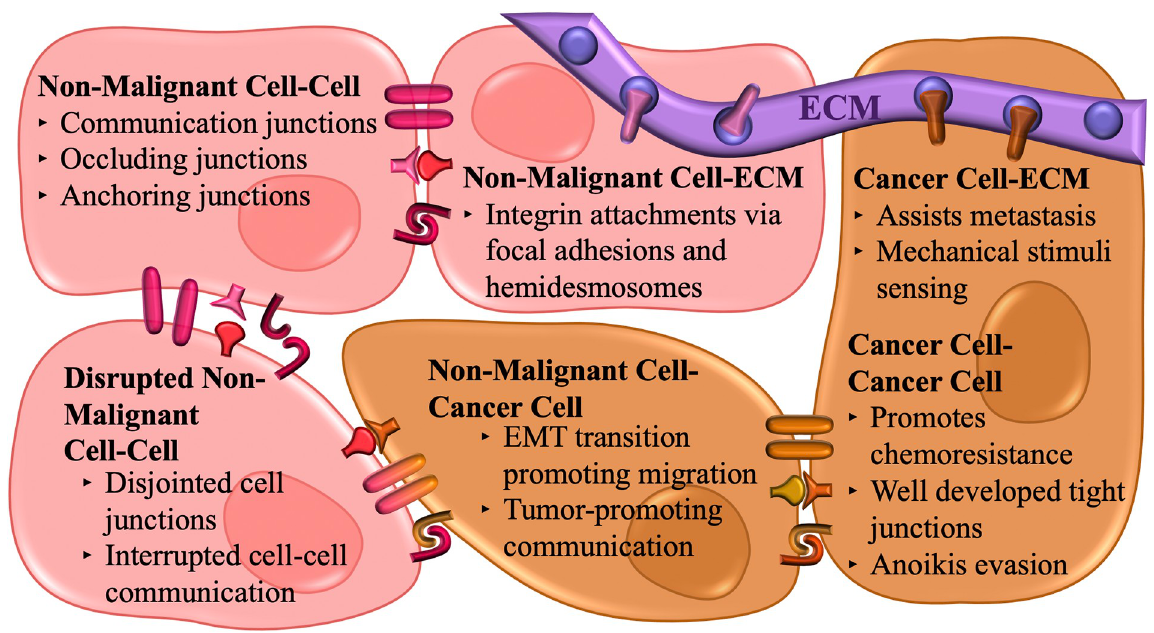
Fig 3. Various cell-cell interactions within the cancer-organ system. Interactions of cancer and malignant cells with their surroundings help dictate their survival and phenotypes. Within the homeostatic non-transformed microenvironment, various cell-cell junctions are formed ensuring the proper polarization, orientation, and proliferation of the non-malignant cells. Cell-ECM interactions provide structure and mechanical stimuli to the cellular surroundings through points of adhesion. These native interactions are disrupted by the infiltrating cancer cells which interrupt cell-cell communications and displace healthy tissue. The cancer cells undergo the epithelial-mesenchymal transition in order to metastasize and do not experience the same proliferative inhibition provided by non-malignant cell-cell communication. Well- established communication between cancerous cells increases survival by avoiding anoikis and promoting chemoresistance. Finally, the surrounding ECM, which is stiffened by the presence of the expanding cancer mass, aids in additional cancer cell migration, and an altered mechanical environment will feed forward the progression of the